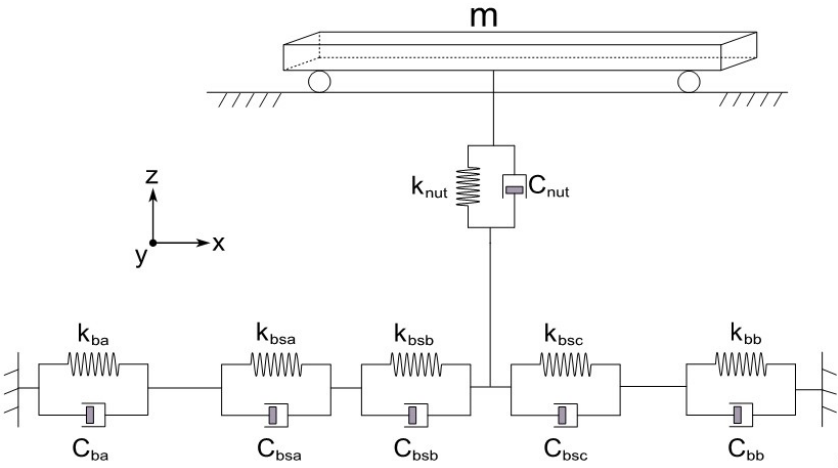
Figure 2. The equivalent dynamic model of the ball screw system.